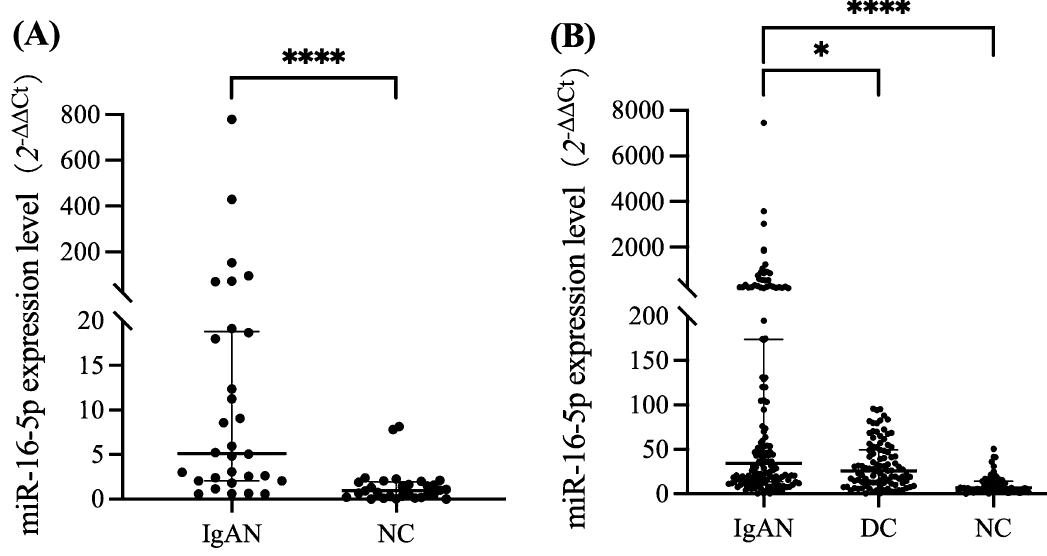
Figure 2. ( A ) Comparison of miR-16-5p expression levels between the IgAN group and normal group in a confirmation cohort. IgAN group, n = 30, Normal control, n = 30. ( B ) Comparison of miR-16-5p expression levels between the IgAN group and Disease control group and normal control group in a validation cohort. IgAN group, n = 144, Disease control, n = 100, Normal control, n = 67. *, P < 0.05; ****, P < 0.0001. miR-16-5p